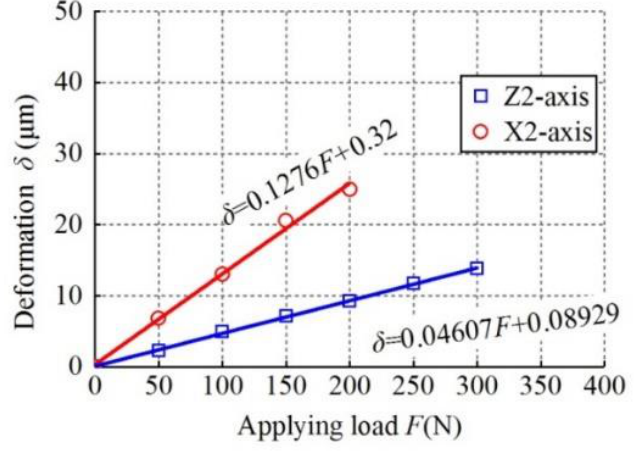
Figure 16. Static stiffness characteristics of the parallel platform.